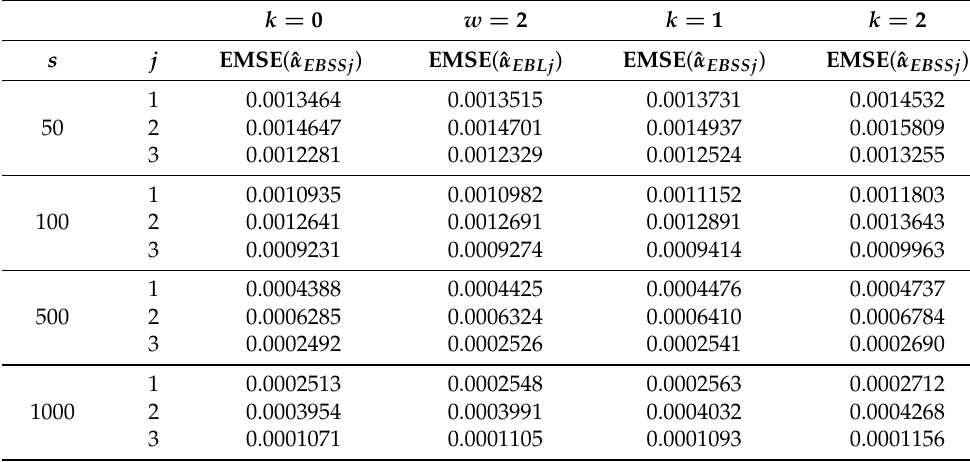
Table 3. Simulated EMSE of ˆ α with n = 50, β = 3, u = 3 and v = 4.